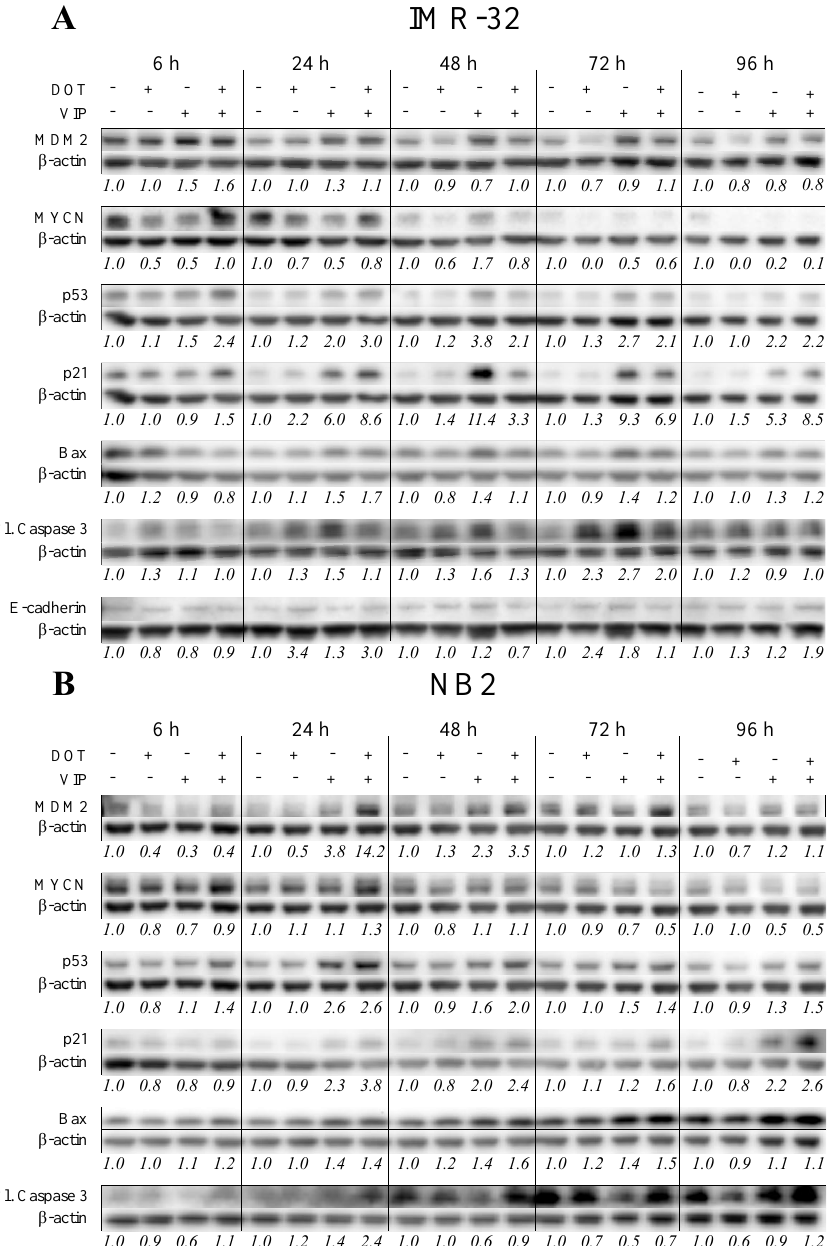
Figure 4. Western blot. Expression of MDM2, MYCN, p53, p21, Bax, cleaved caspase 3 and E-cadherin in ( A ) IMR-32 and ( B ) NB2 6 – 96 h after treatment with 177 Lu-DOTATATE and/or VIP116. Representative data from one experiment. Intensity values, shown below each band, was normalized against the loading control (β -actin) and the corresponding untreated control for each time point. Intensity plot from all replicates can be found in Figure S6.